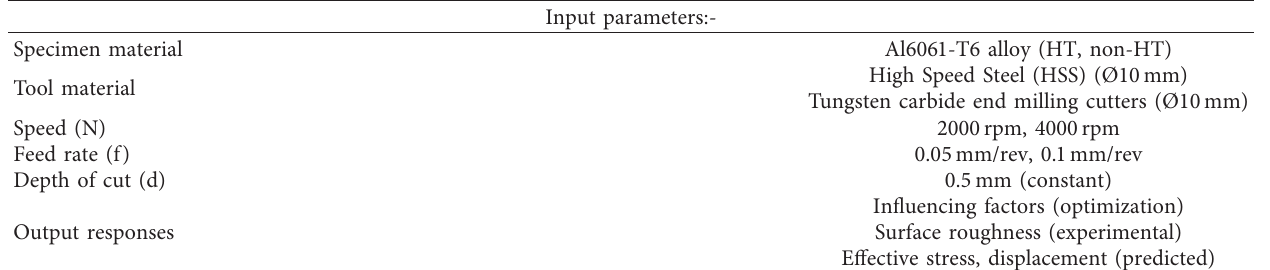
Table 2: Machining conditions.